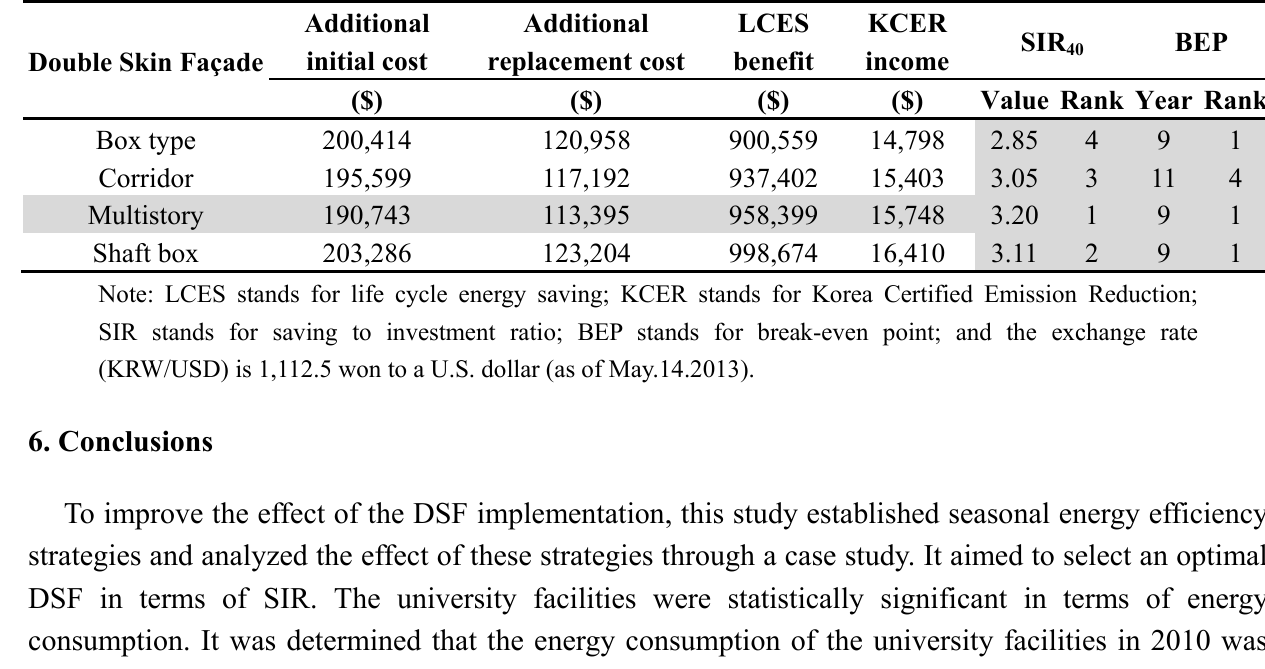
analyses on four DSF with seasonal energy efficiency Table 8. LCC and LCCO 2